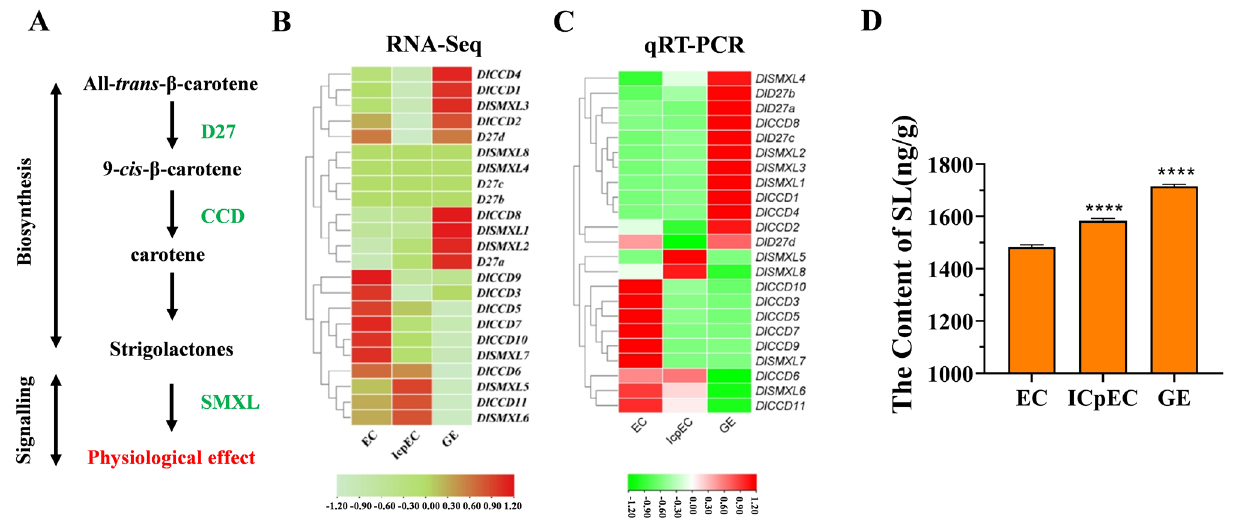
Figure 5. ( A ) Roles of CCD, D27, and SMXL genes in SLs pathway. ( B ) FPKM values of members of DlCCD, DlSMXL, and DlD27 family in longan SE. ( C ) Relative expression levels of DlCCD, DlSMXL, and DlD27 family in longan SE. ( D ) Changes in the endogenous SL content in longan SE. “****” ( p < 0.001).